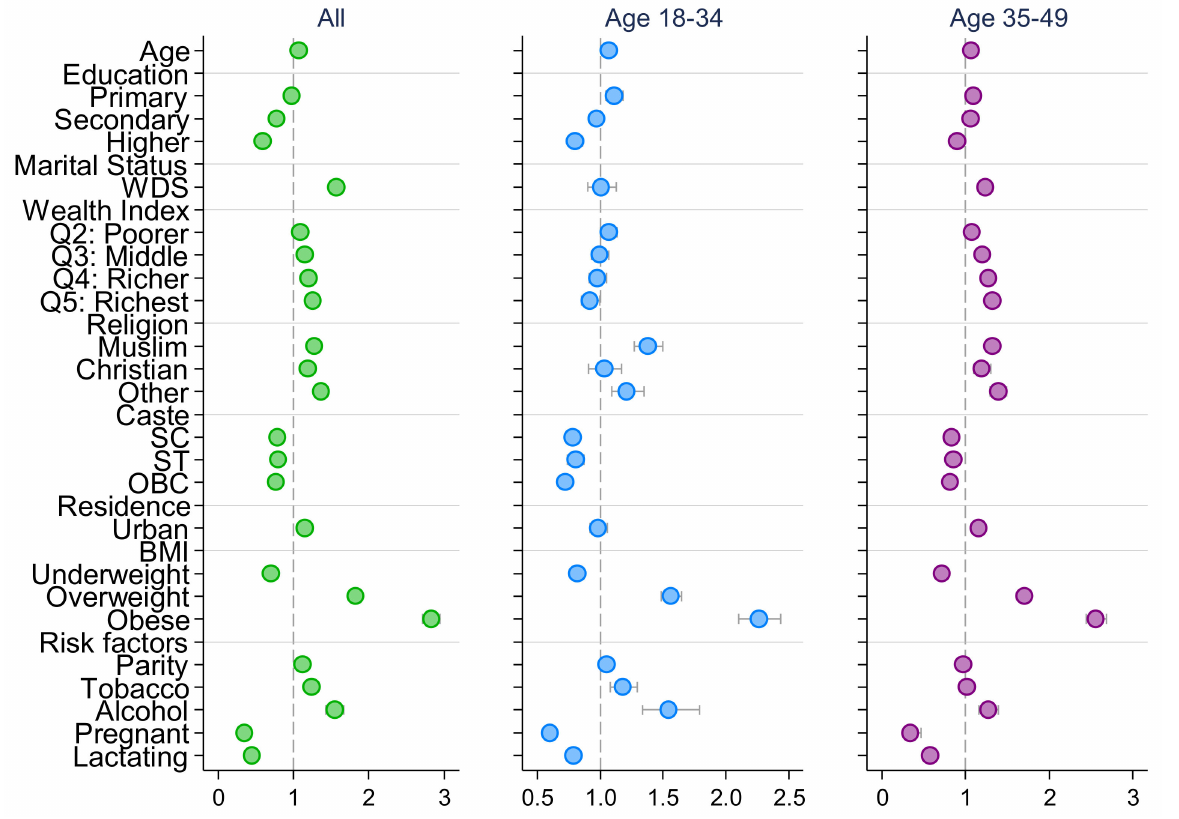
Figure 3. Crude odds ratios in favor of having high blood pressure for the covariates. Estimates were obtained using complex survey weights. The horizontal lines across the markers represent 95% confidence intervals. The base categories of each categorical variable are as follows: